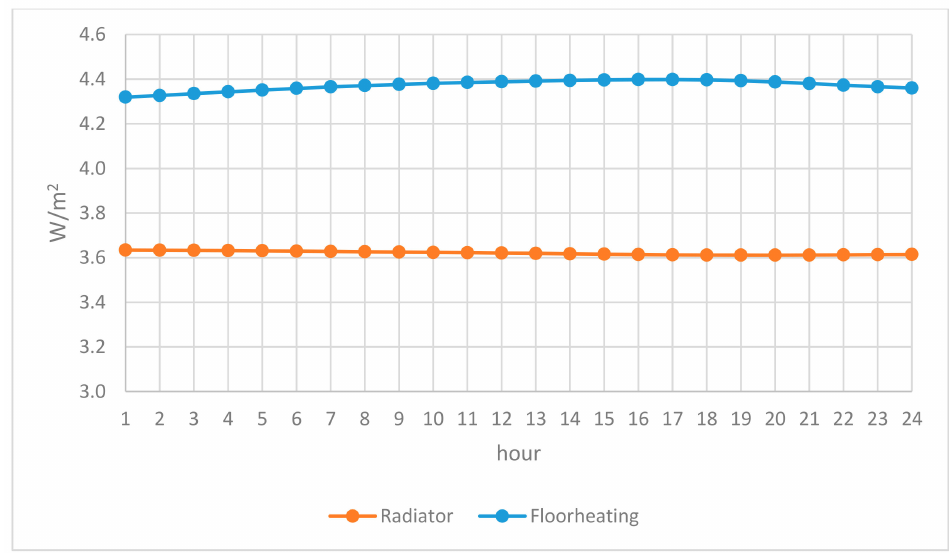
Figure 9. Floor transmission heat loss profile for the studied passive building with radiator and floor heating systems on the design day.